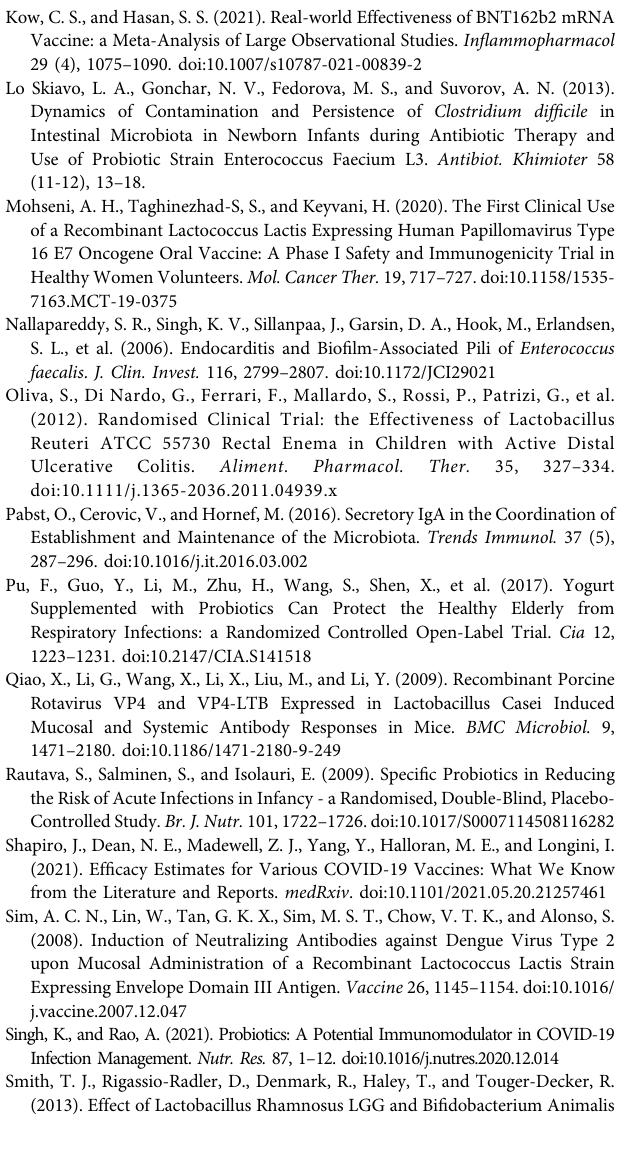
Supplementary Figure S2 | PAGE analysis of recombinant protein SarsS and immunoblotting with antibodies from COVID-19 patients. The recombinant protein SarsSwassubjectedtopolyacrylamide gelelectrophoresis (PAGE)and stained with (lane A) Amido Black; the same protein was transferred to nitrocellulose membrane (lane B) and blotted with IgG obtained from COVID-19 patients as described in Immunization schemes and antibodies and Western blotting . 1) SarsS protein. 2) Protein molecular weight marker. 3 – Immunoblotting of SarsS being transferred on the nitrocellulose with IgG obtained from COVID-19 patients. Supplementary Figure S3 | Immune response to subcutaneous immunization of mice with protein SarsS on Day 42 after the fi rst injection. Supplementary Figure S4 | Chromosomal DNA region of Enterococcus with the nucleotide sequence of the integrated plasmid DNA pentF-sarsS . DNA primers B1 and K2 used for sequencing are highlighted in bold. SupplementaryFigureS5| DetectionofproteinSarsSinlysateof E.faecium L3by Western blotting. Enterococcal proteins were separated by electrophoresis in 10% PAGE, transferred to a nitrocellulose membrane and blotted with commercial monoclonal antibody (AtaGenix Laboratories, Wuhan, China), speci fi c to S1 protein of